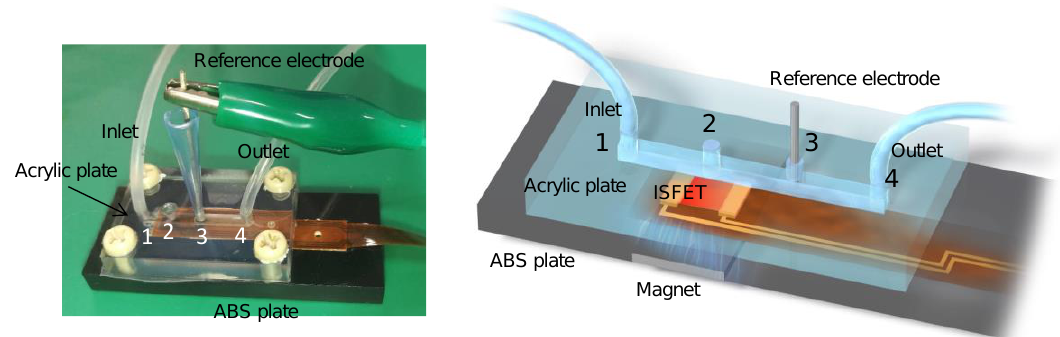
Figure 2. The microfluidic system including the MCC-based ISFET sensor. Four holes were made in an acrylic plate for the inlet (first hole) and outlet (fourth hole) to allow the flow of a measurement solution, for the injection of reagents (second hole), and for the insertion of a reference electrode (third hole). An ISFET sensor was set exactly under the second hole on an acrylonitrile butadiene styrene (ABS) plate, and a button magnet was placed under the sensor area to fix magnetic beads on the gate insulator.